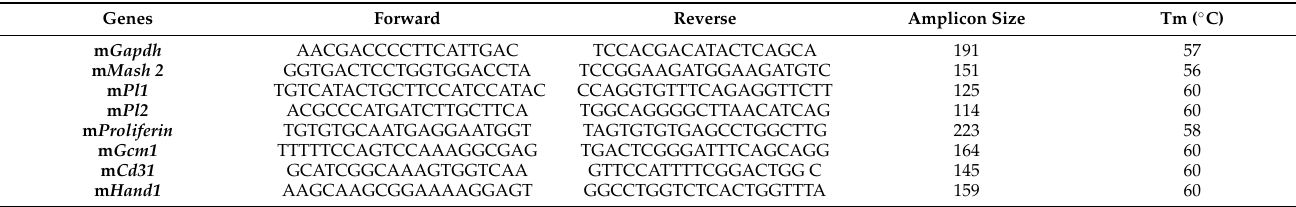
Table 1. Shows the list of the primers used to perform q-PCR in the